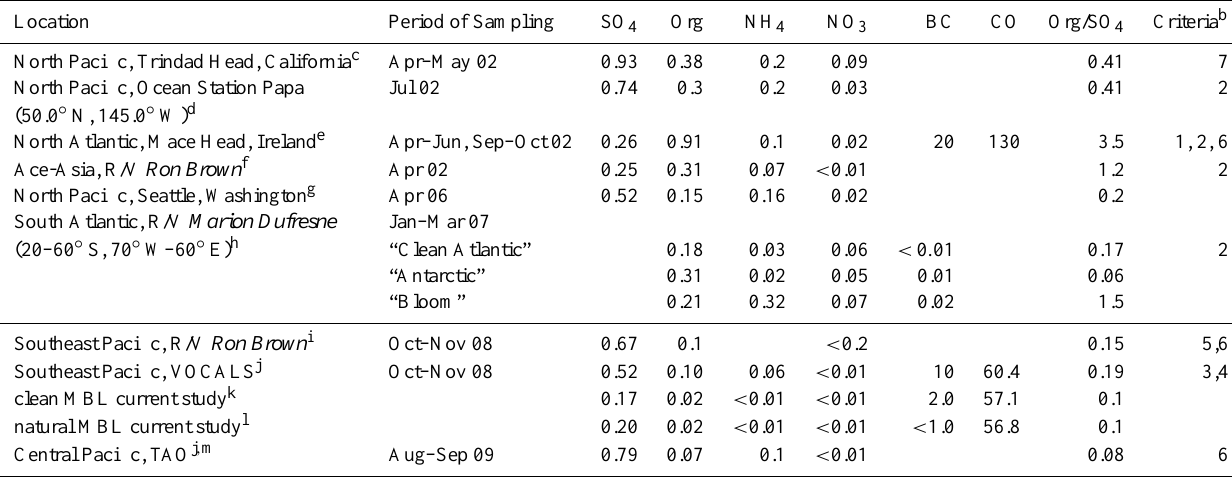
Table 1. Average submicron mass concentrations for major aerosol constituents from current and previous investigations of “clean” marine submicron aerosol a .